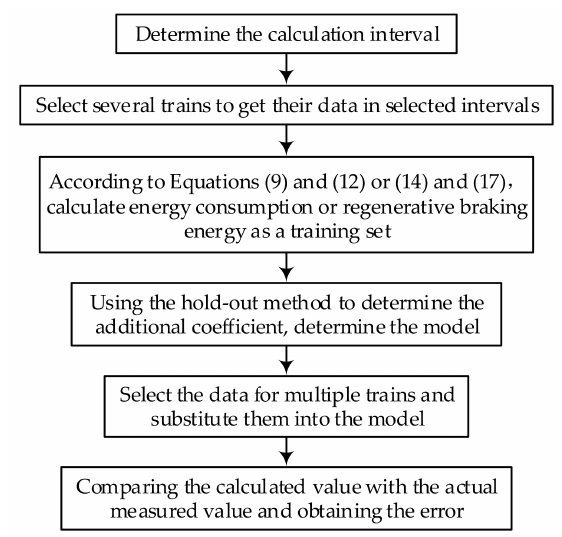
Figure 8. The flowchart to calculate train energy consumption and regenerative braking.